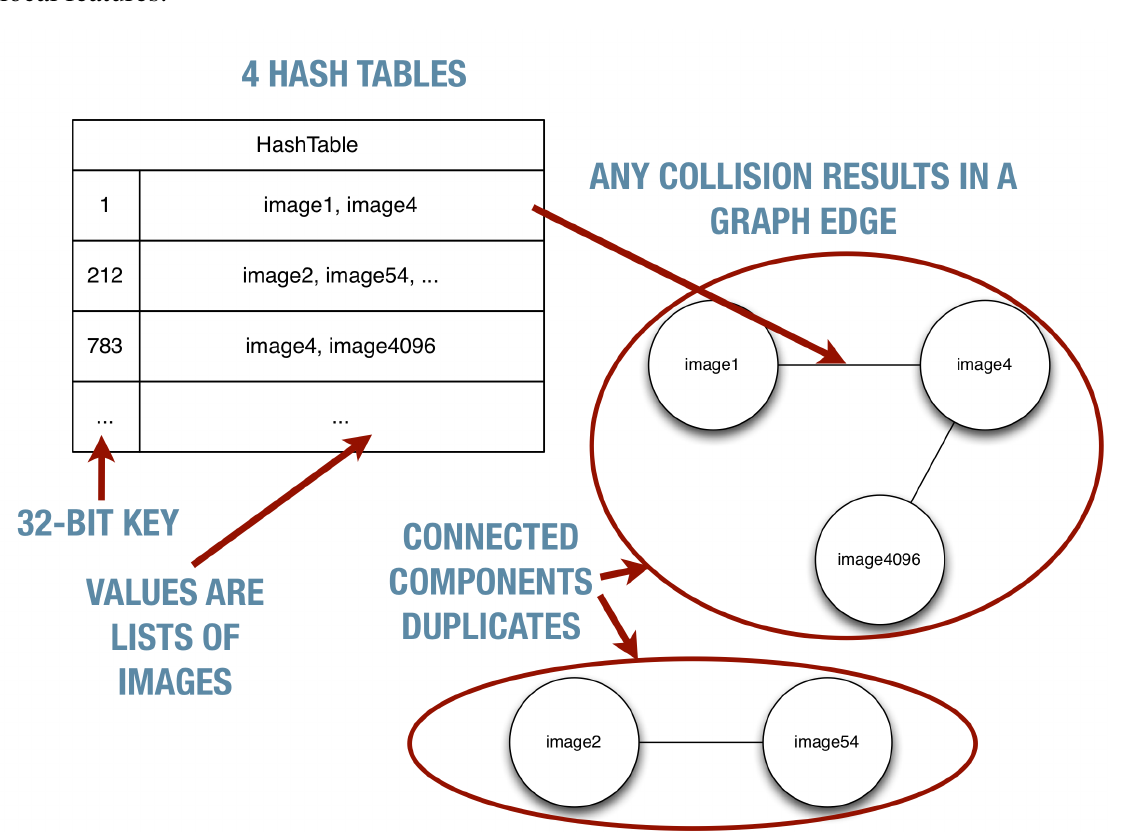
Figure 2. Constructing a duplicate graph from the four hash tables created from sketches of local